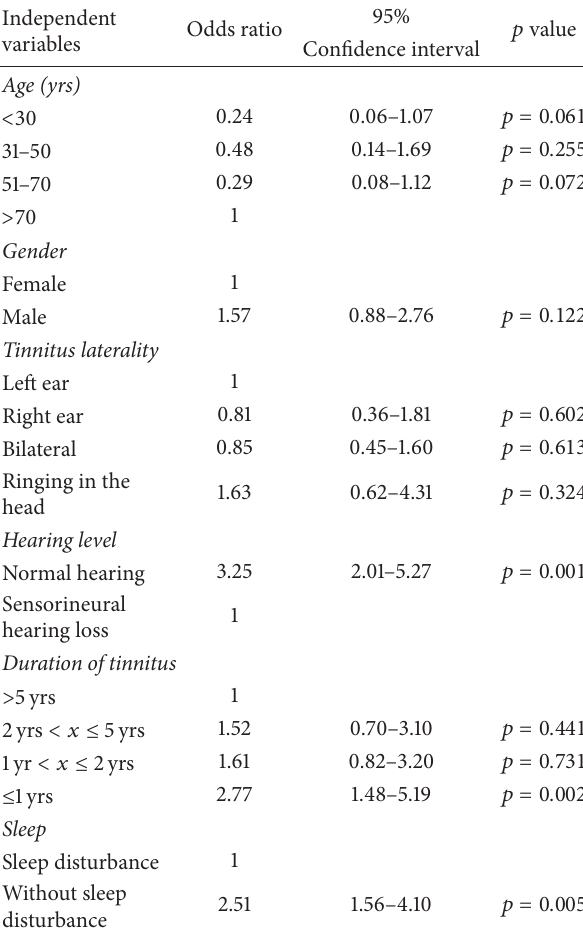
Table 2: Multivariate stepwise logistic regression analyses models for different factors that contribute to tinnitus